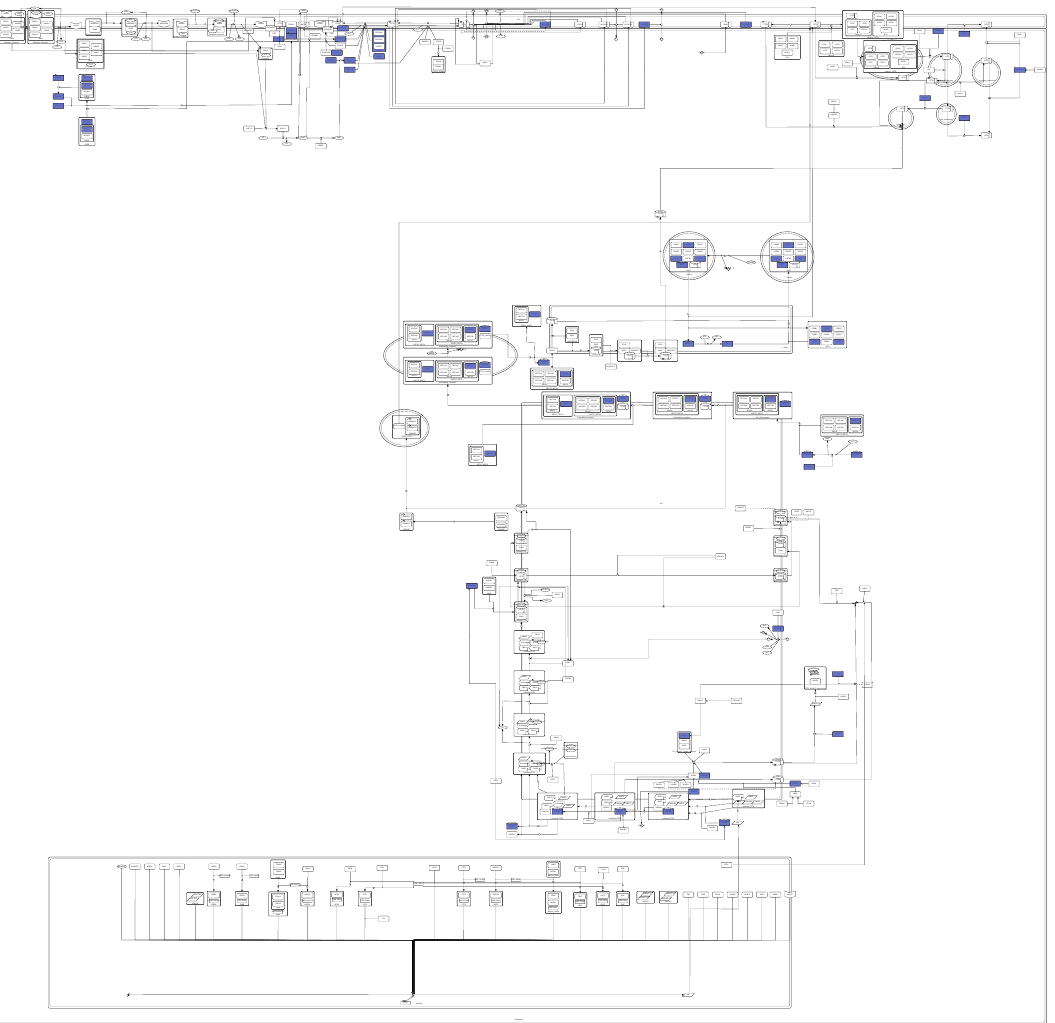
Figure 1. Available protein structures of targets in the CFTR Lifecycle Map. Highlighted in blue are all proteins of which an appropriate PDB structure could be found and which were used as targets in the target-based